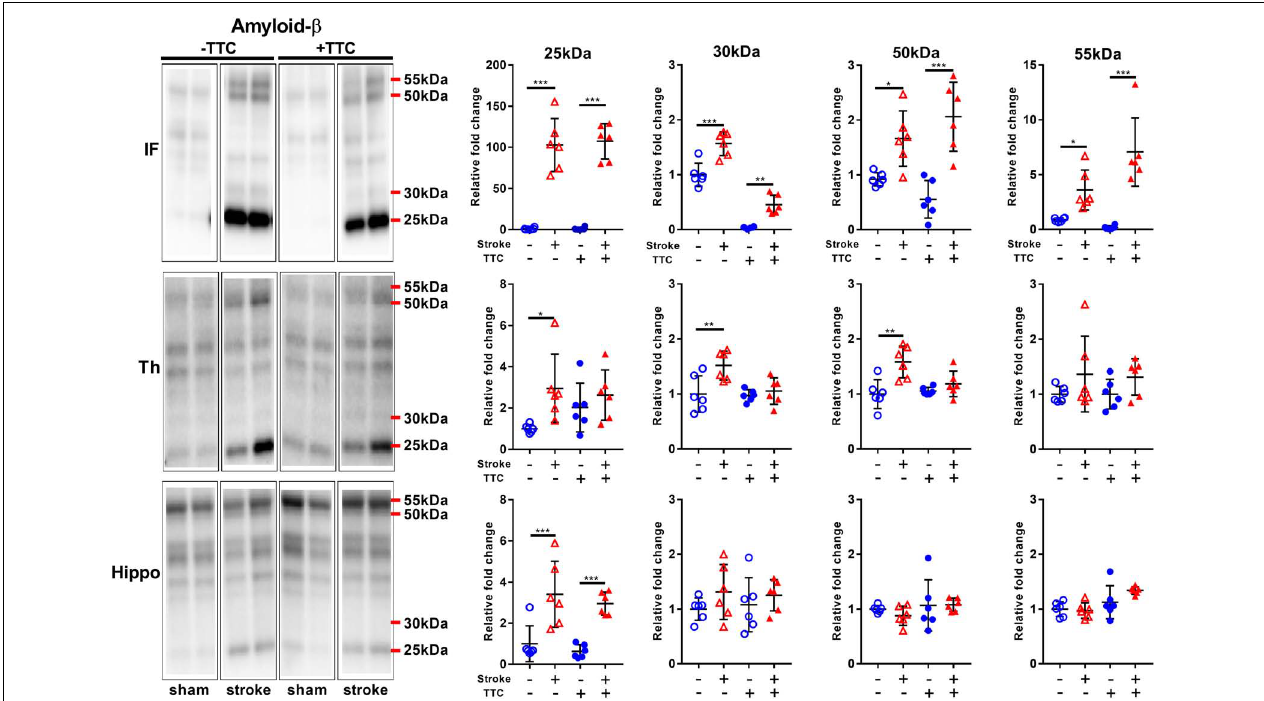
FIGURE 5 | Representative western blot and quantification of amyloid- β expression profile within the infarct (IF), thalamus (Th), and hippocampus (Hippo). Our analyses focused on different molecular weight oligomers (25, 30, 50, and 55 kDa). Mean ± SEM (two-way ANOVA and Sidak’s multiple